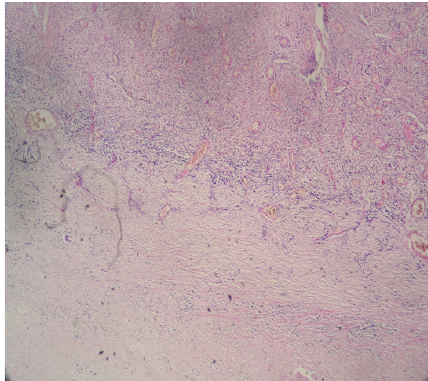
Figure 5: Histopathological slide showing collagenous wall and dense chronic inflammatory